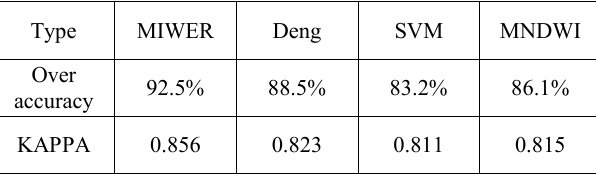
Table 2. Precision comparison of different water extraction